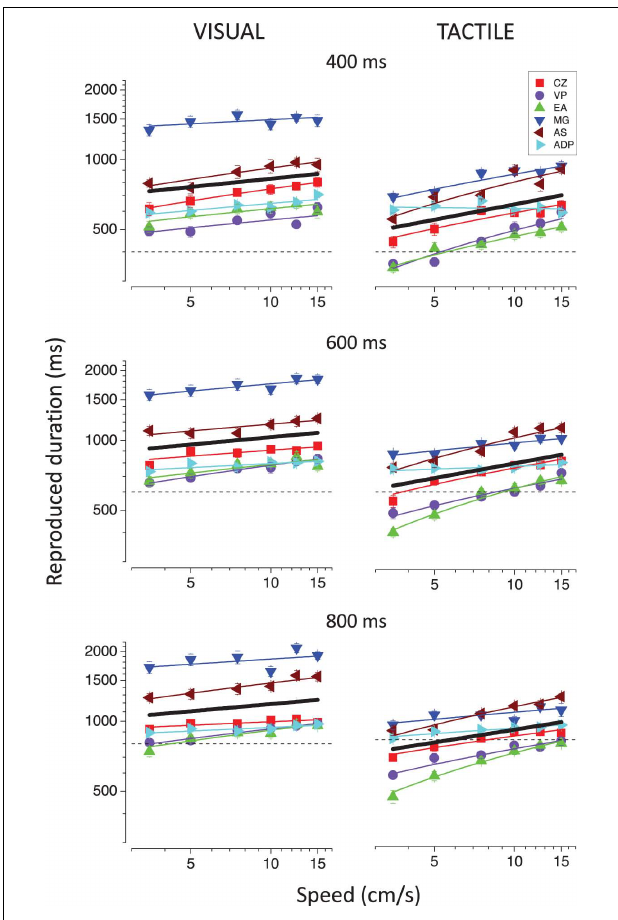
FIGURE 2 | Individual reproduced durations as a function of speed for the visual (left column) and the tactile (right column) stimuli. Different colors represent different subjects.The black solid lines represent the best-fitting linear functions for the average reproduced durations.The results for the 400, 600, and 800ms durations are reported in the upper, middle, and lower panels, respectively.The dashed lines indicate the actual physical durations of the stimuli.